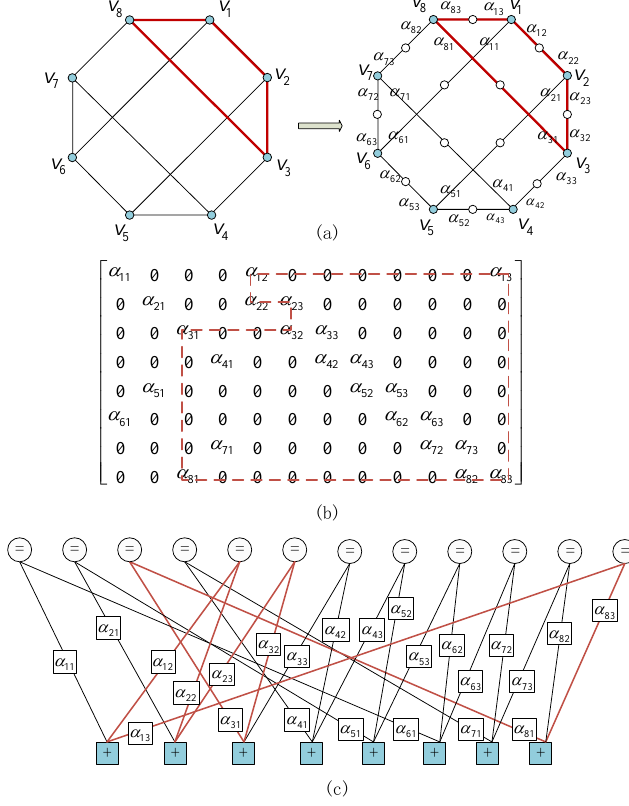
Figure 1. ( a ) The mapping from an eight-vertex Hamiltonian graph to an non-binary low-density parity-check (NB-LDPC) code, where v 1 , v 2 , · · · , v 8 correspond to the check node, and α 11 , α 12 , · · · , α 83 are non-zero elements over the Galois field. ( b ) The parity-check matrix of the code associated with the Hamiltonian graph. ( c ) The Tanner graph of the code associated with the Hamiltonian